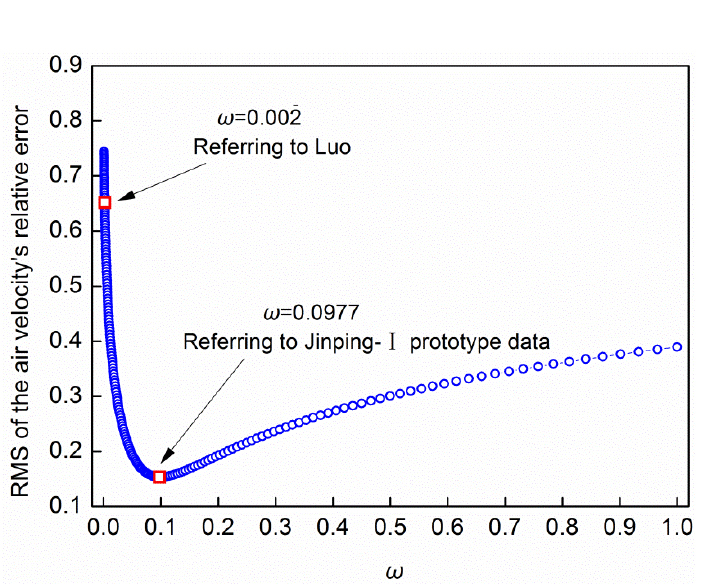
Figure 6. The trial results of the constant term in the drag coe ffi cient